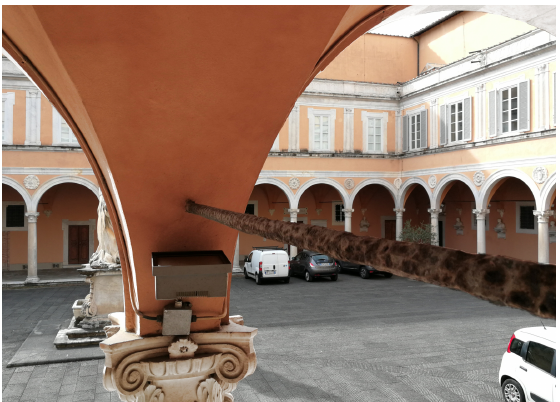
Figure 12. Internal courtyard of the Palazzo Arcivescovile. A total of 30 tie-rods are installed in the vaulted corridor surrounding